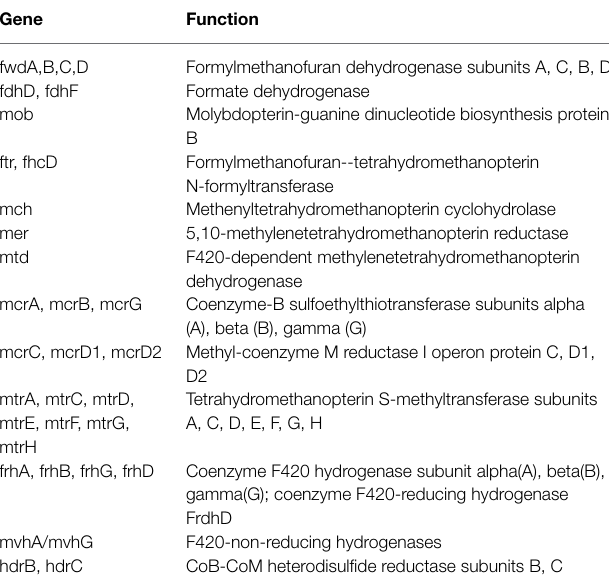
TABLE 6 | Genes involved in the CH 4 formation pathway from H 2 and CO 2 (KEGG: M00567) found in the annotated genome of Methanobacterium formicicum (GenBank: JADIIL000000000) and Methanobrevibacter arboriphilus (GenBank: JADIIN000000000) from the TCE/Cr(VI) biocathode and the corresponding